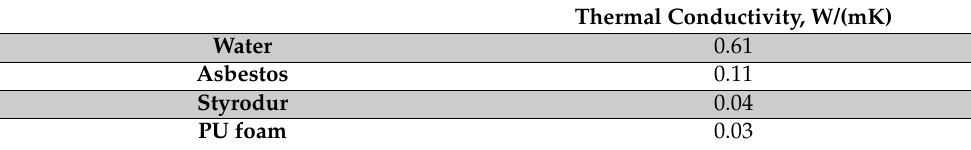
Table 3. Thermal conductivity of selected materials.